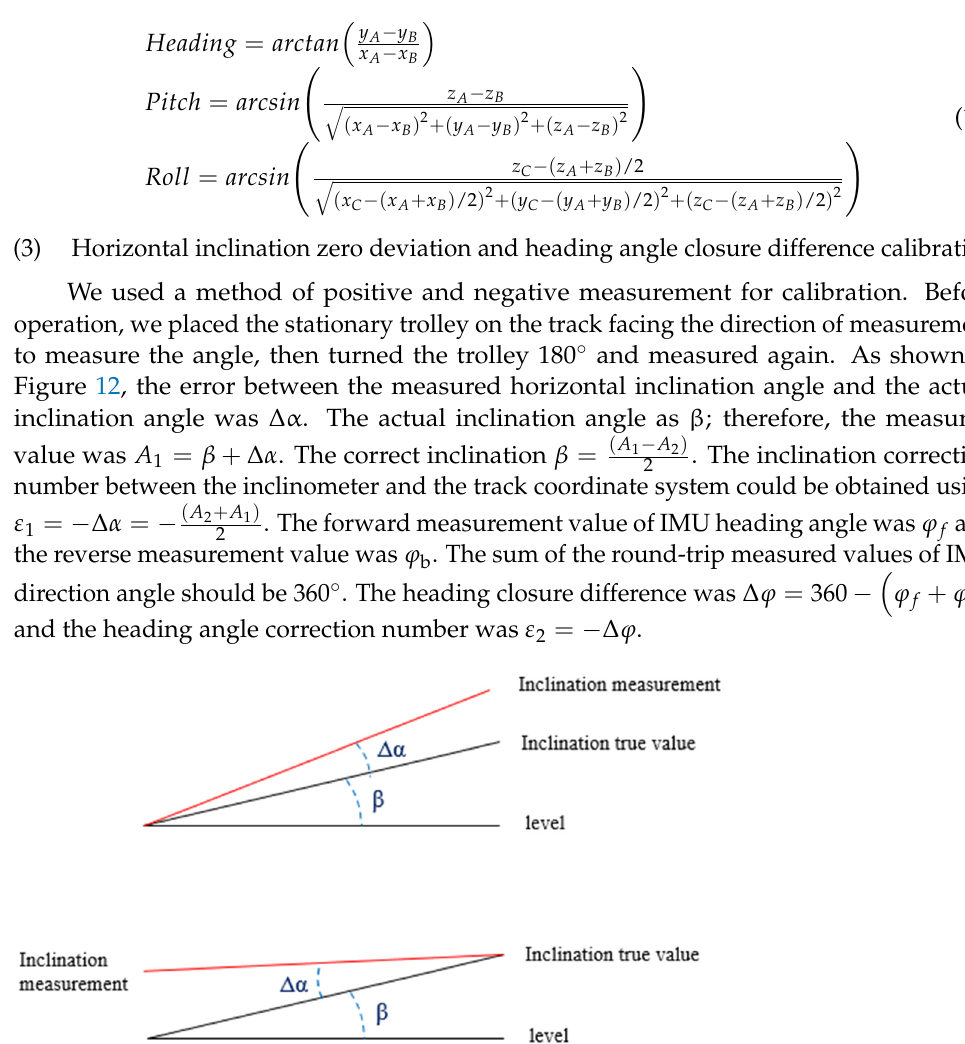
Figure 12. Schematic diagram of inclination